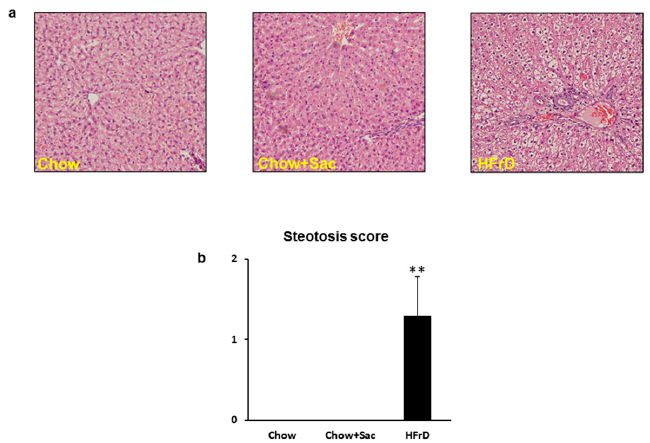
Figure 1. Rats fed HFrD developed a fatty liver. ( a ) Representative slides, hematoxylin eosin staining of liver tissue showing steatosis changes only in rats fed HFrD (high fructose diet) but not in the Ctrl (control) or Sac (saccharine) group (40× magnification, n = 9–10); ( b ) steatosis score-ranked by a pathologist according to an objective scale. ** p < 0.01 vs. chow and chow + Sac.